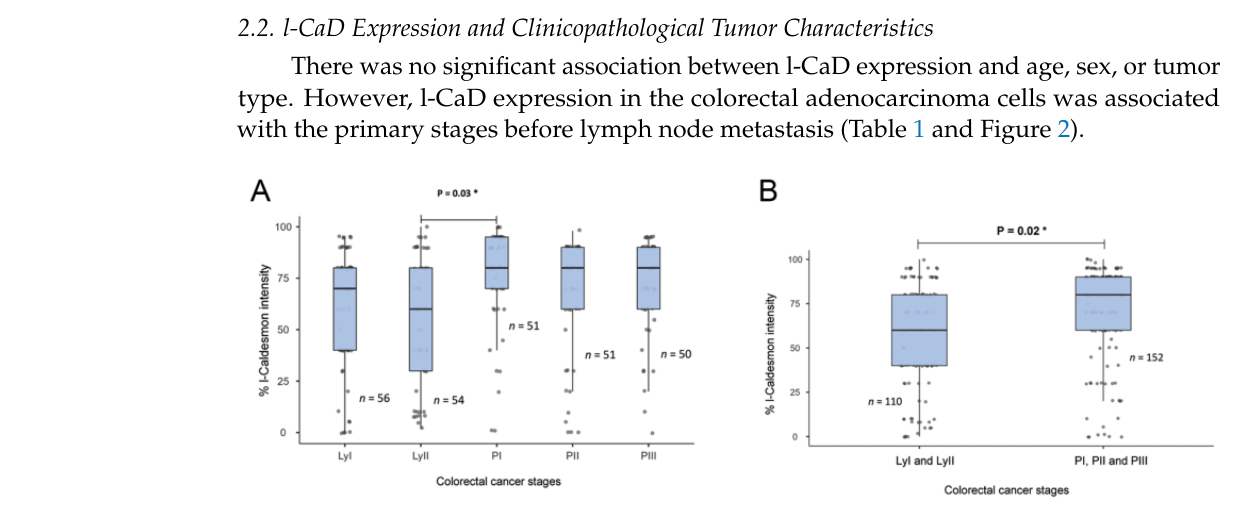
Table Footnote. * Differences in the total number were due to missing data. # Other histological types were signet ring cell carcinoma, serrated adenocarcinoma, mixed adeno-neuroendocrine carcinoma, mucinous carcinoma, combined/mixed carcinoid and adenocarcinoma, and in situ adenocarcinoma. Tumor stages at the time of tumor diagnosis were re-assessed according to the 8th edition TNM classification for tumor staging. Abbreviations: l-CaD, low molecular weight caldesmon, N.S., non-significant (>0.05); TNM, T: tumor, N: lymph node; M: metastasis; UICC, Union for International Cancer Control. A detailed explanation of the TNM stages can be found in the 8th edition of the American Joint Committee on Cancer (AJCC) staging manual [27].